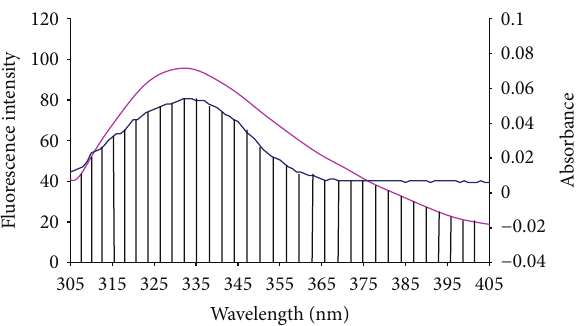
= 2.0×10 −6 mol L −1 ) with absorption spectra of liquiritigenin ( 𝐶 HAase